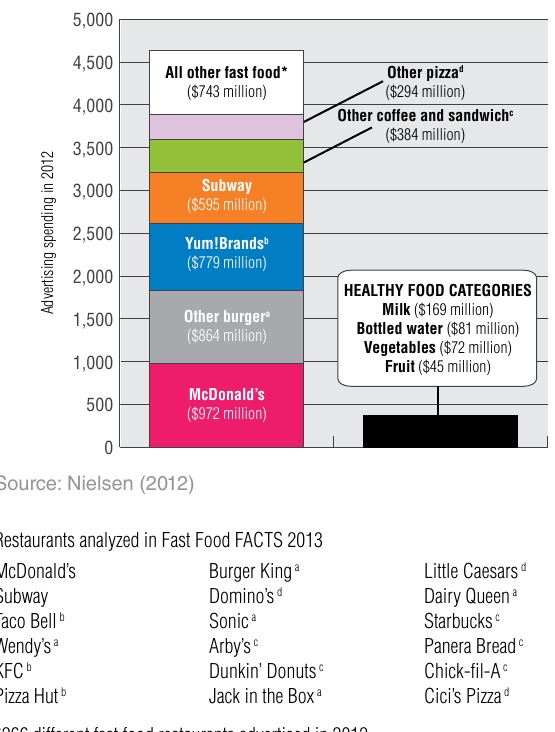
Figure 18. Advertising spending for fast food restaurants versus healthy food categories